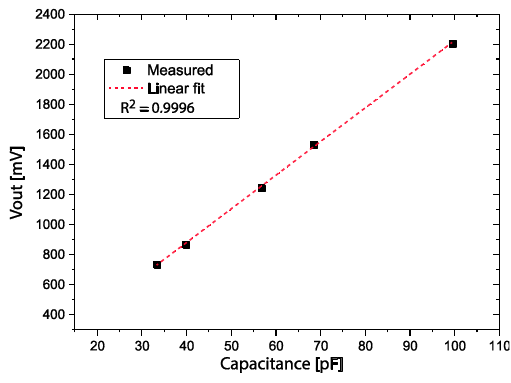
Figure 8. V out as a function of the